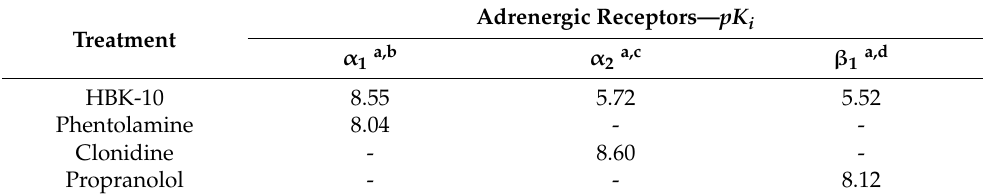
Table 1. The affinity of HBK-10 for adrenergic α 1 , α 2 , and β 1 receptors.